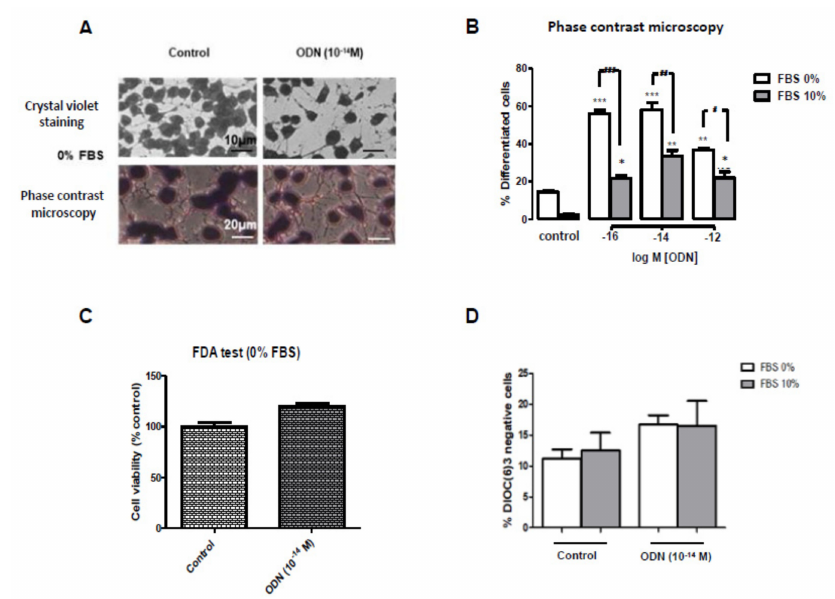
Figure 1. E ff ect of ODN on neuronal di ff erentiation and cell viability in N2a cells. Murine neuronal N2a cells, previously cultured for 24 h in conventional culture medium, were further cultured for 48 h in medium with 10% FBS or without FBS (0% FBS) or in the presence or absence of octadecaneuropeptide (ODN: 10 − 16 to 10 − 12 M). To distinguish between undi ff erentiated and di ff erentiated cells (cells characterized by neurite outgrowth), cells were either stained with crystal violet and observed by brightfield microscopy, or were directly observed by phase contrast microscopy ( A ); the percentage of di ff erentiated cells was quantified on cells observed by phase contrast microscopy ( B ). At the concentration of ODN (10 − 14 M) inducing the highest percentage of di ff erentiation (in the absence of FBS), the impact of ODN on cell viability was quantified by fluorimetry with the FDA assay ( C ), and by flow cytometry after staining with DiOC 6 (3) which allows to measure transmembrane mitochondrial potential ( ∆Ψ m) ( D ). In the conditions inducing the highest percentage of di ff erentiation (ODN 10 − 14 M; 0% FBS), di ff erent types of cells were distinguished after staining with crystal violet or by phase contrast microscopy ( A ): undi ff erentiated cells (without neurites); di ff erentiated cells (neurites 5–10 µ m length); di ff erentiated cells (one or more neurites > 10 µ m without or with neurites 5–10 µ m length). Each value corresponds to the mean ± standard deviation (SD) of four independent experiments. ANOVA followed by Bonferroni’s test: * p < 0.05, ** p < 0.01; *** p < 0.001 (ODN-treated versus untreated cells); # p < 0.05;